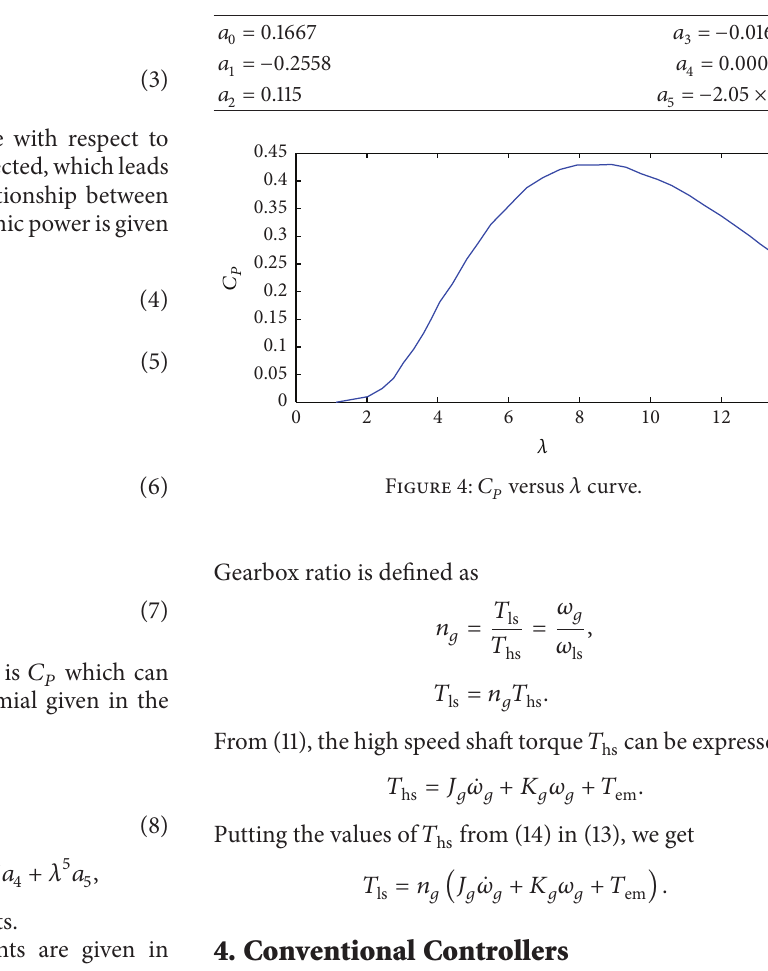
Table 1: Coefficients’ values.